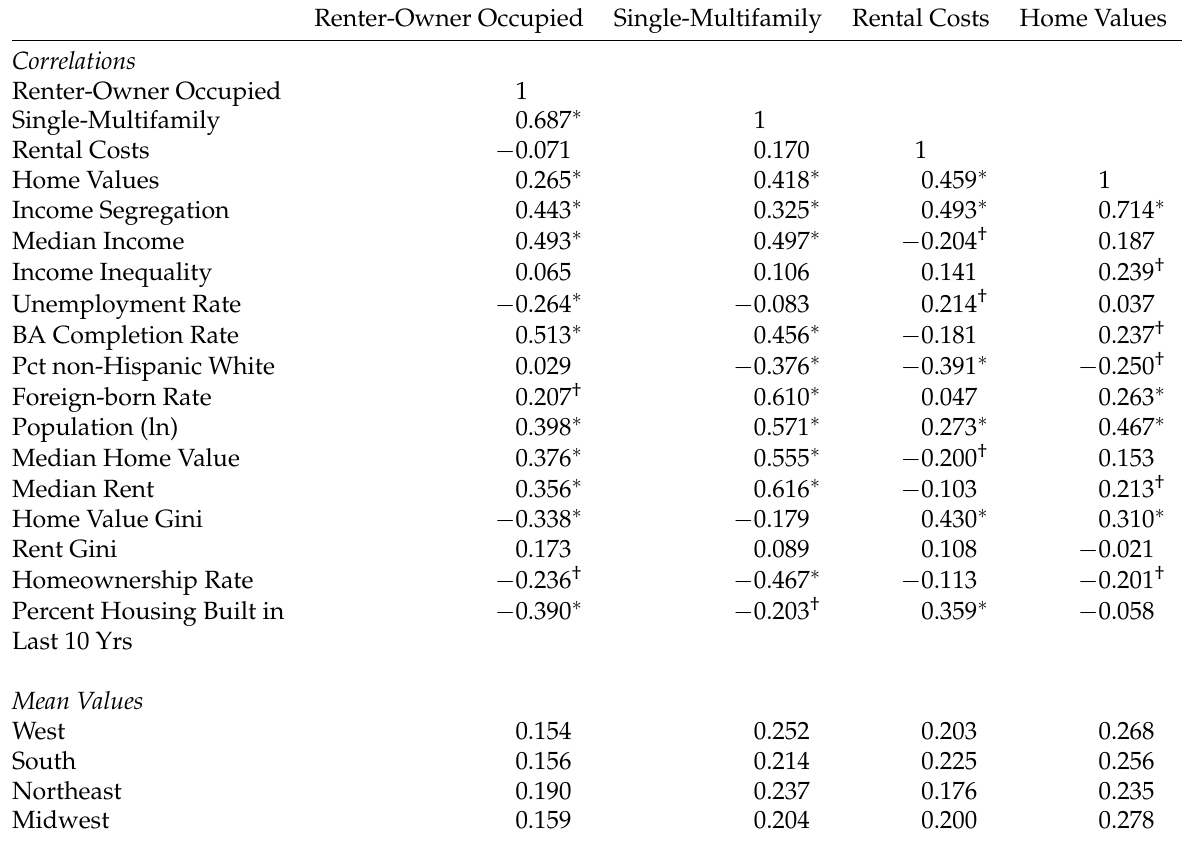
Table 2: Correlates of housing segregation between neighborhoods, 2014. Renter-Owner Occupied